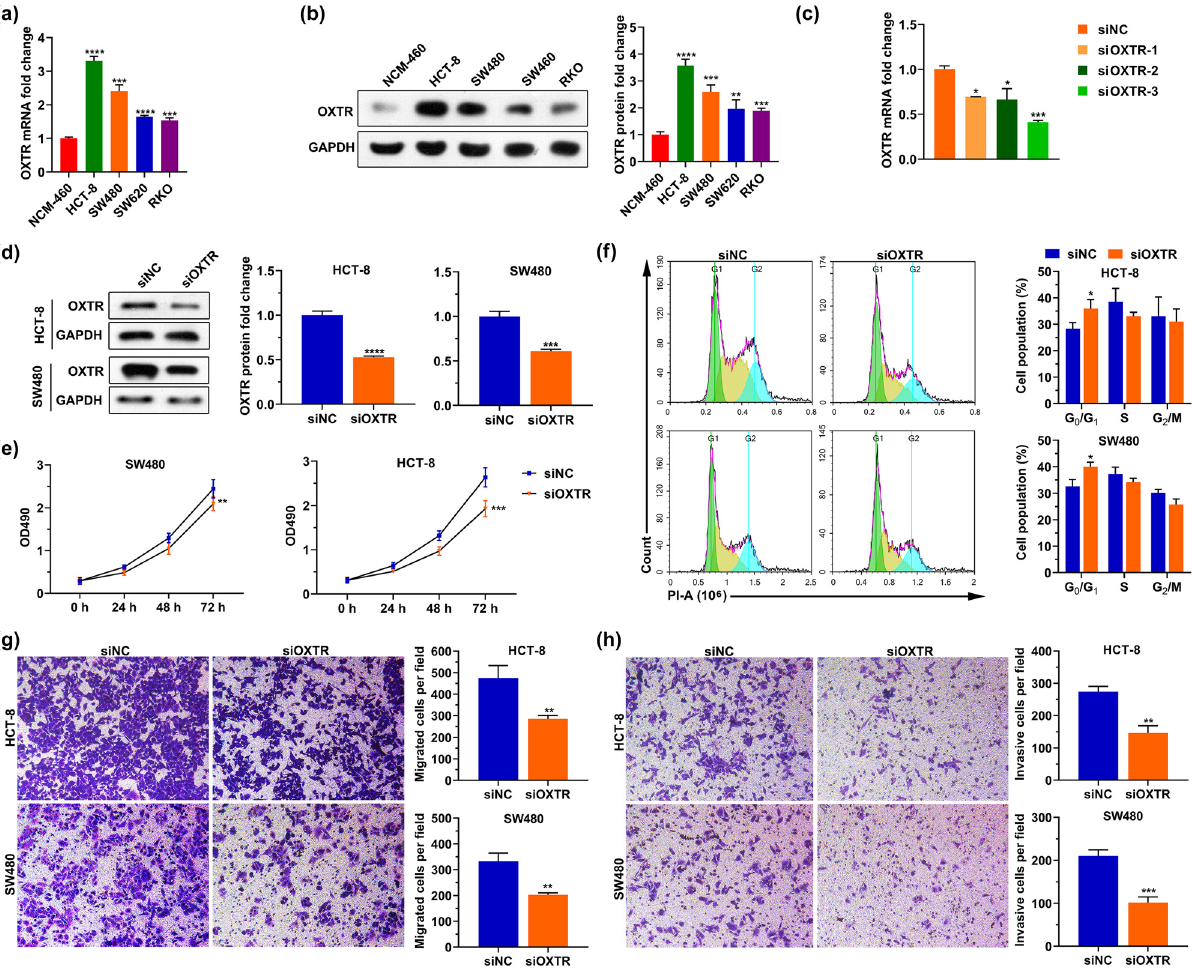
Figure 9: Silencing OXTR inhibits cell proliferation, migration, and invasion. ( a and b ) OXTR mRNA ( a ) and protein ( b ) levels in human normal colonic epithelial cell line ( NCM - 460 ) and COAD cell lines ( HCT - 8, SW480, SW620, and RKO ) . ( c and d ) After HCT - 8 and SW480 cells were transfected with siOXTR, qPCR ( c ) and western blotting ( d ) assays were used to analyze the levels of OXTR mRNA and protein in the cells, respectively. ( e ‒ h ) After silencing OXTR, MTT assay, PI staining, and transwell assay were used to detect cell proliferation ( e ) , cell cycle ( f ) , migration ( g ) , and invasion ( h ) . siOXTR: small interfering RNA of OXTR; siNC: the negative control of siOXTR; PI: propidium iodide.